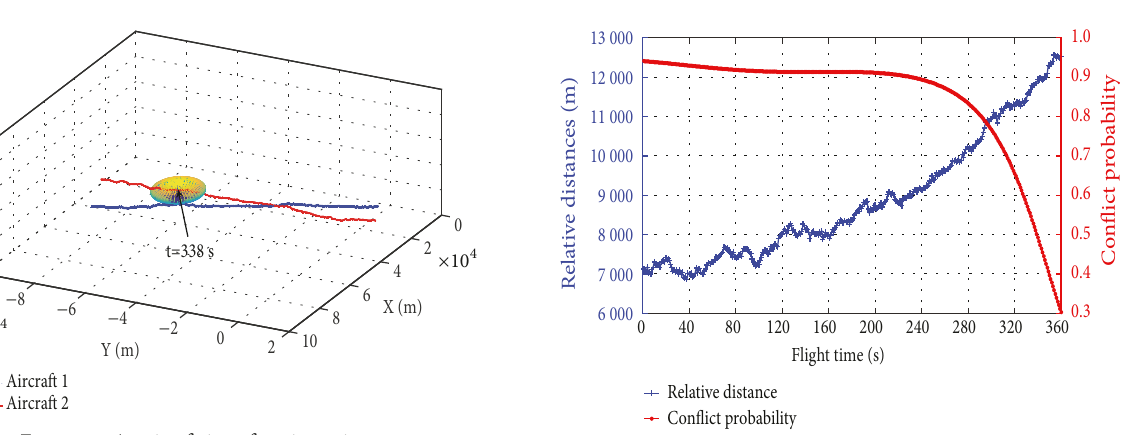
Figure 8: Flight time-distances/conflict probability relationship in departure